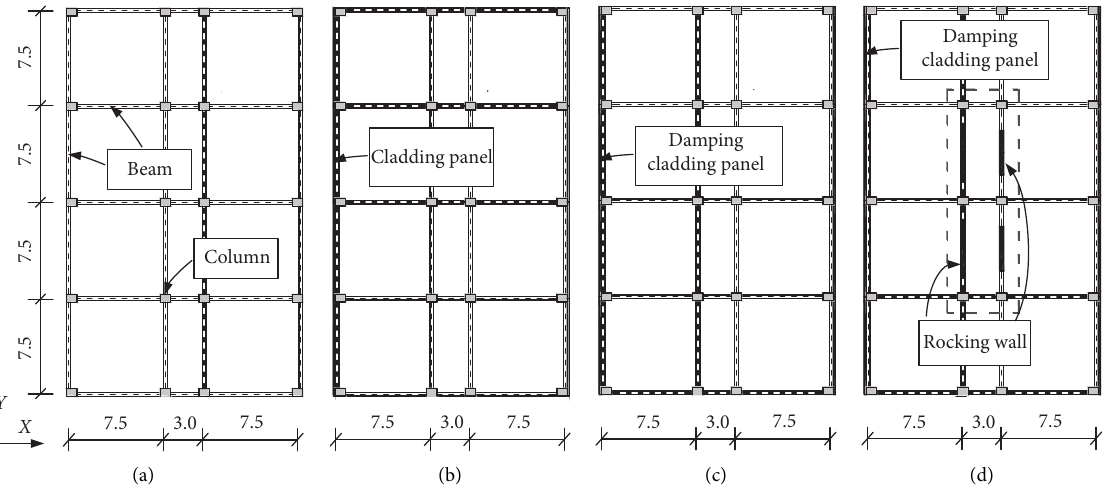
Figure 4: Benchmark model and three kinds of contrast models (unit: m). (a) Benchmark model. (b) PRCFCP. (c) PRCFCP-USD. (d) PRCFCP-USD-RW.